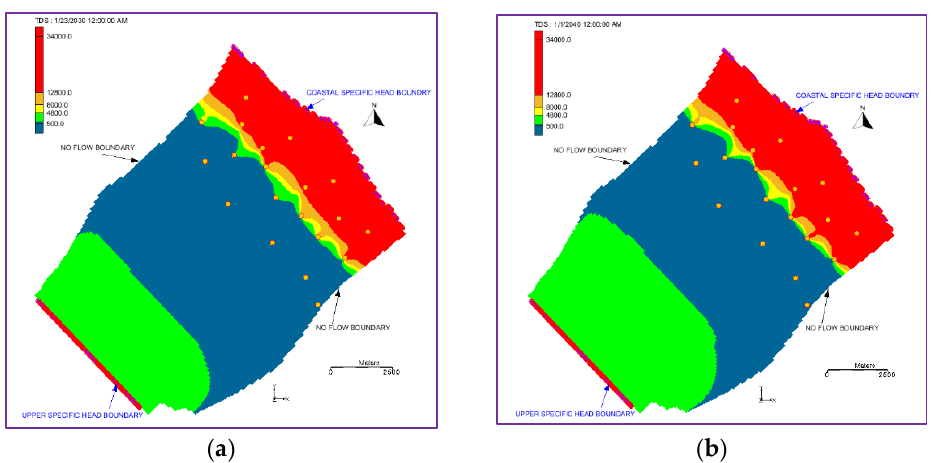
Figure 7. Salinity contours for Scenario-2 (pumping rates increased by 10% from those in the year 2017). ( a ) 2030 and ( b ) 2040.